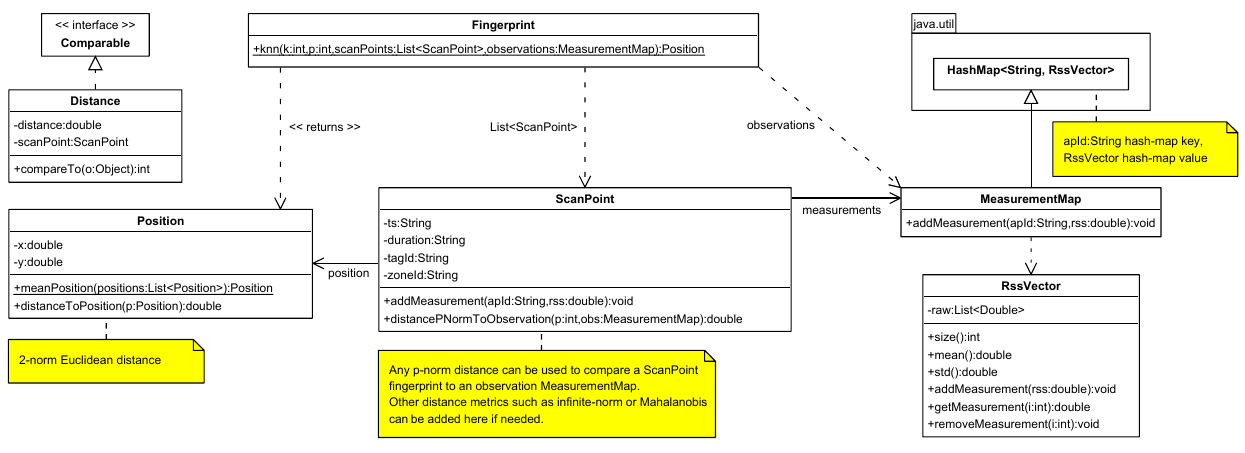
Figure 9. UML class diagram representing how to implement any Fingerprinting algorithm in any language (e.g., a KNN programmed in